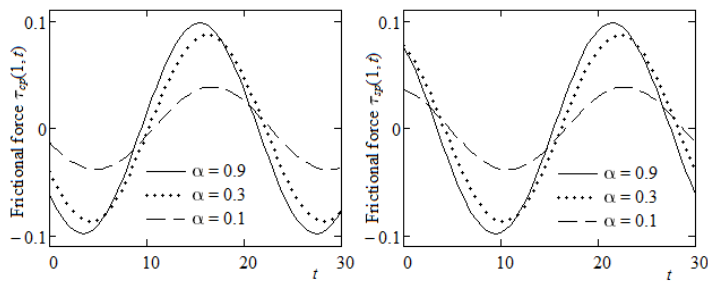
Figure 5. Time variations of the frictional forces per unit area τ cp ( 1, t ) and τ sp ( 1, t ) for Re = 100,We = 1, ω = π /12 and decreasing values of α .